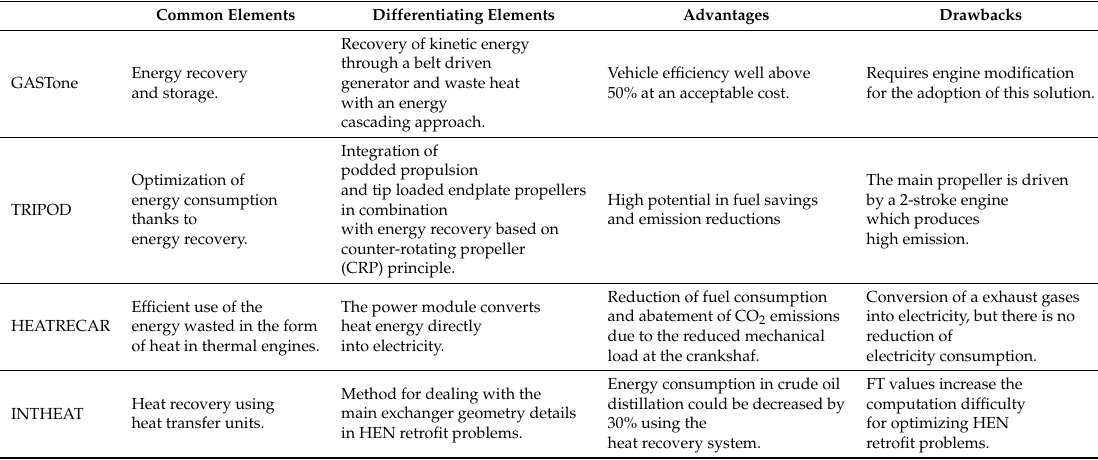
Table 1. Summary of proposals for waste energy recovery in other